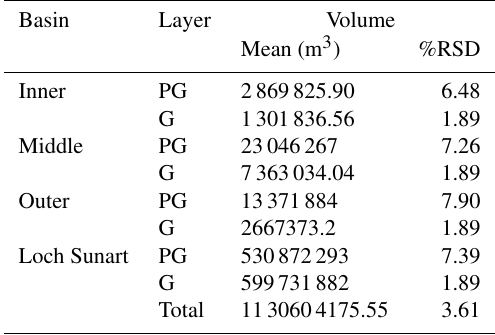
Table 3. Sediment volume calculated as the mean of the three nu- merical integration algorithms; the error is reported as relative stan- dard deviation (%RSD) which integrates the uncertainty in the seis- mic interpolation and the standard deviation of the numerical inte- gration algorithms. The data are reported for the postglacial (PG) and glacial (G) sediment at the basin